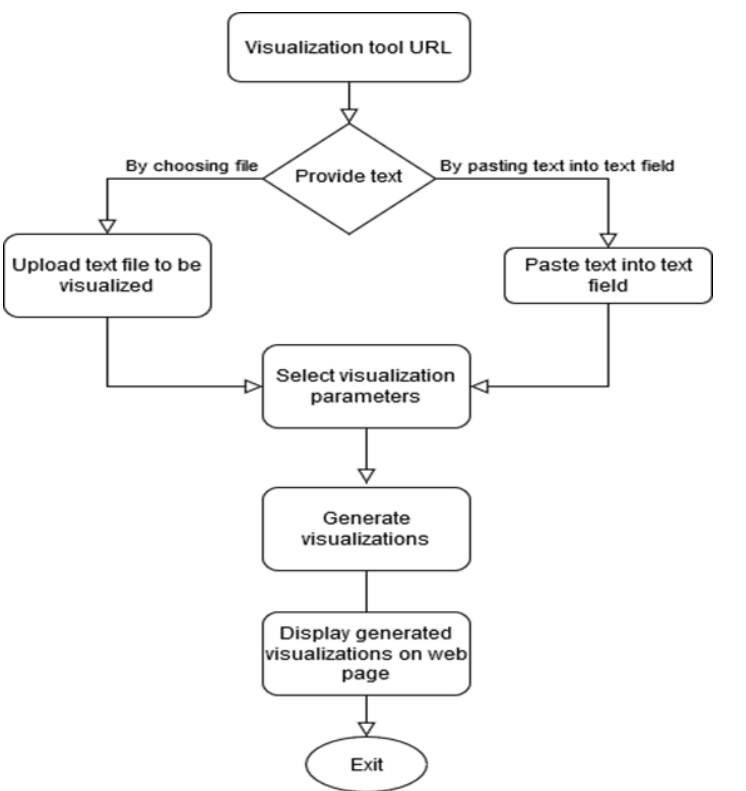
Figure 1. Text Visualisation Tool (TVT) workflow. The user opens TVT tool in a web user interface where he can provide the text to be analysed. One can also modify the text visualisation parameters (e.g., number of expected topics) or keep the default values. Finally (after the user clicks “generate”) the visualisations are generated and displayed in the web user interface.